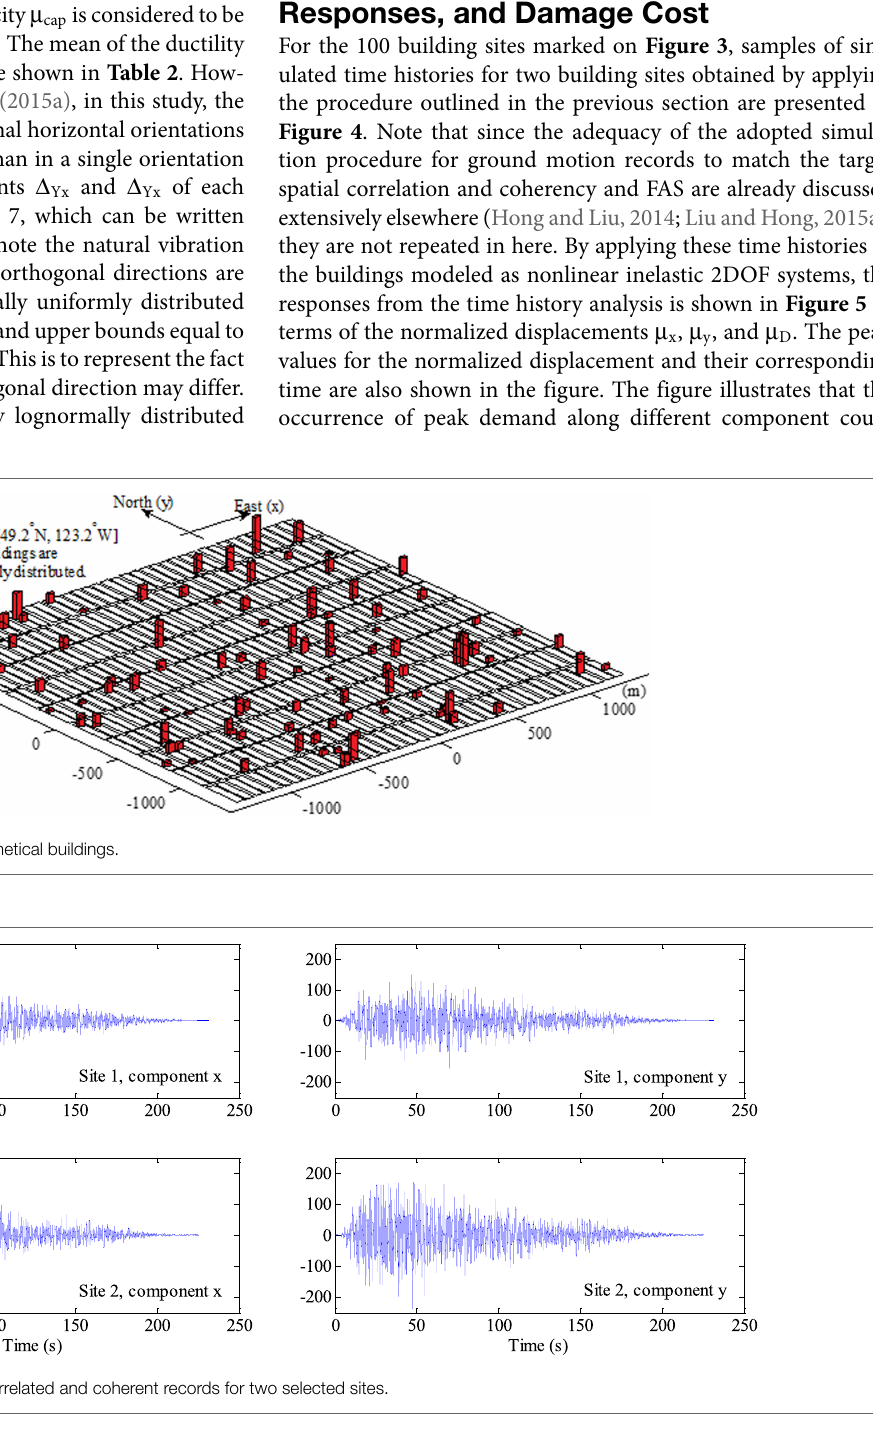
Fr ontiers in Built Environment |